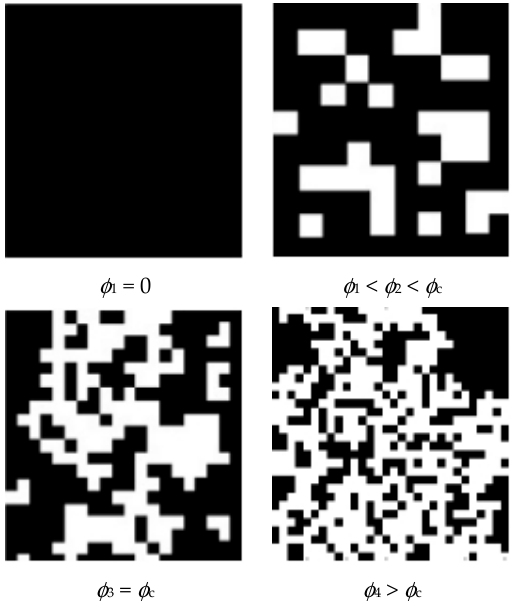
Figure A2. Single-layer grid sealing interface gap-schematic diagram of skeleton change.